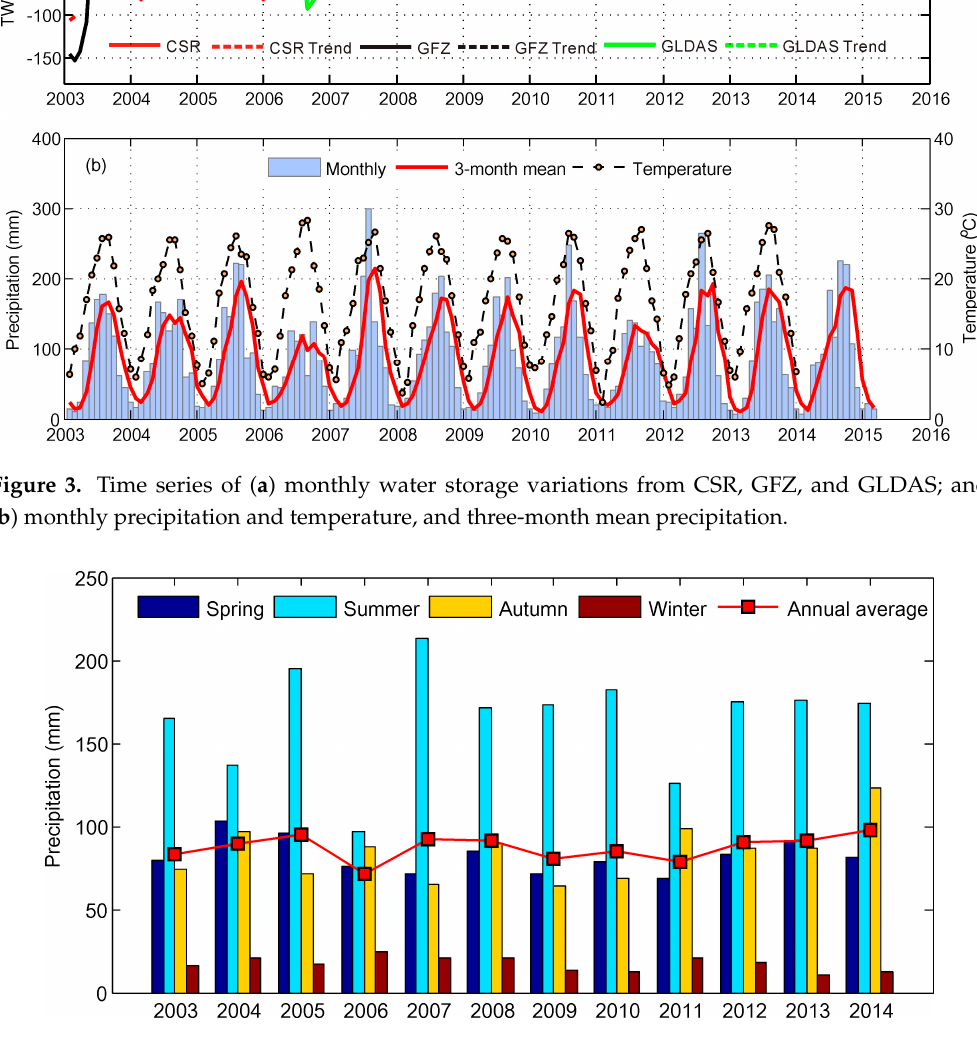
Figure 4. Figure 4. Seasonal and annual average precipitation in the Sichuan